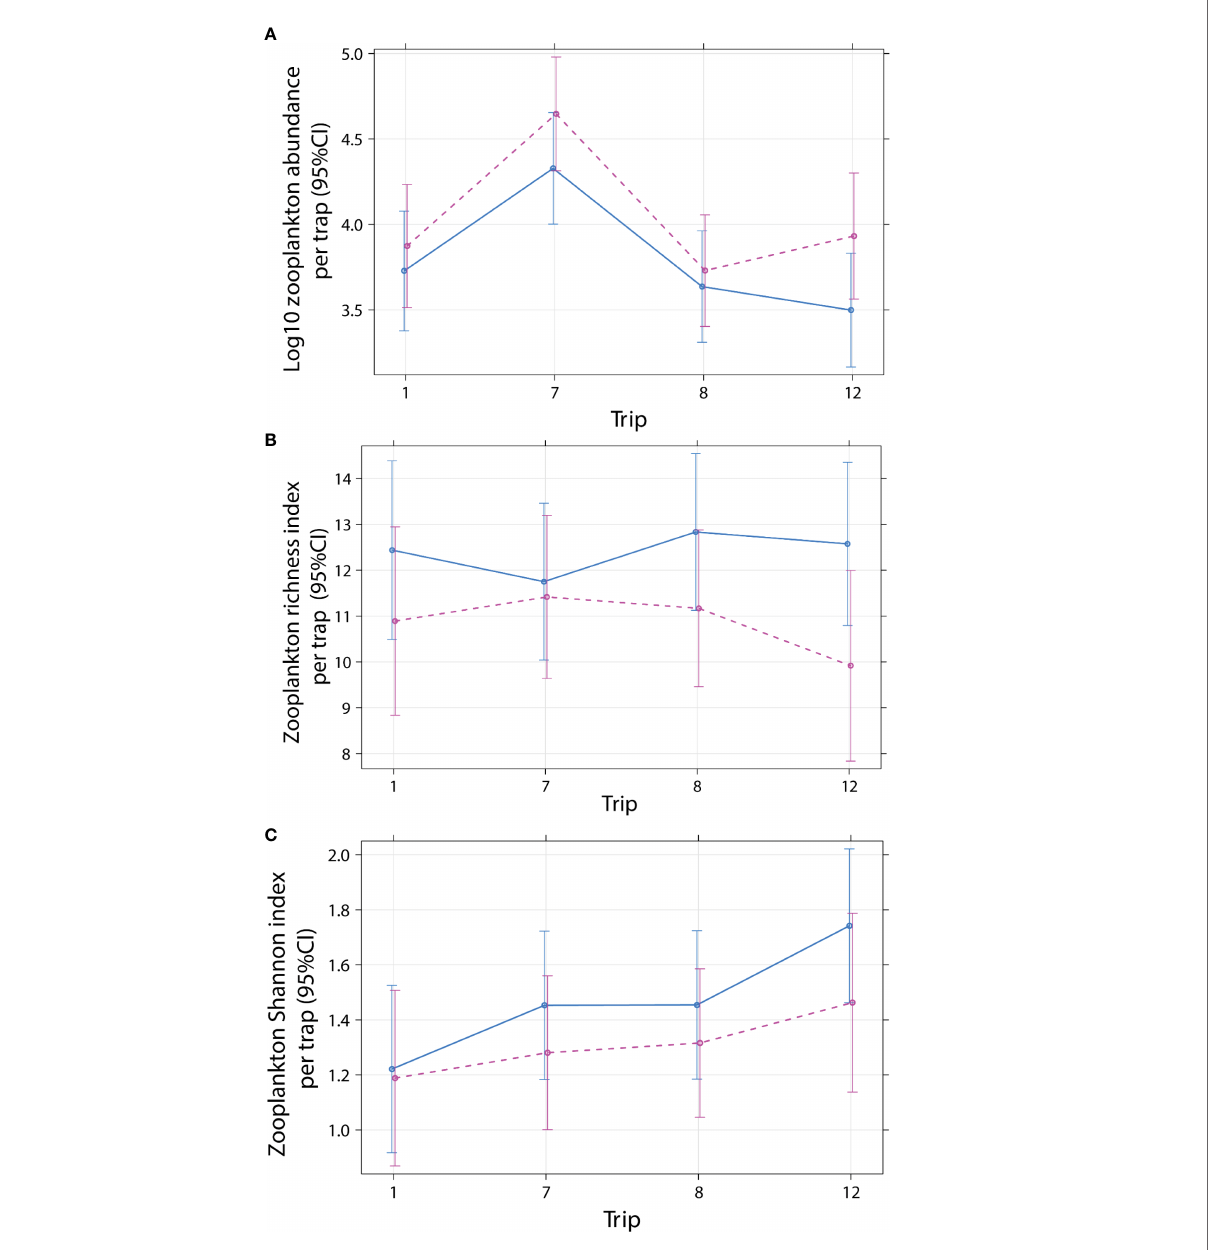
FIGURE 3 | Effect plot for mean zooplankton (A) log10 abundance, (B) richness, and (C) Shannon diversity index per emergence trap (1 m -2 ) for cleaner fi sh Labroides dimidiatus presence treatment (Control = yes cleaner fi sh present [solid line]), Removal = no cleaners present [dashed line] by sampling trip (1 = July 2000, 7 = January 2002*, 8 = June 20002, 12 = December 2012). * P < 0.05 for trip, relative to trip 1. Two outliers were omitted (see Materials and Methods